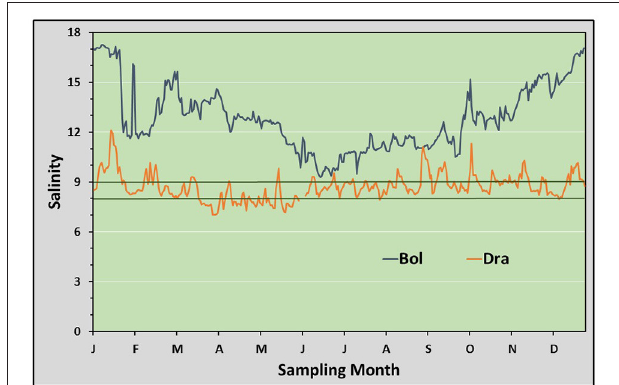
FIGURE 3 | Salinity: Mean salinities based on data collected from 2012 to 2015. The westernmost (Boltenhagen) and the easternmost (Dranske) sampling sites are shown. The limiting lower salinity for Teredo navalis (between 8 and 9) is indicated by dark-green